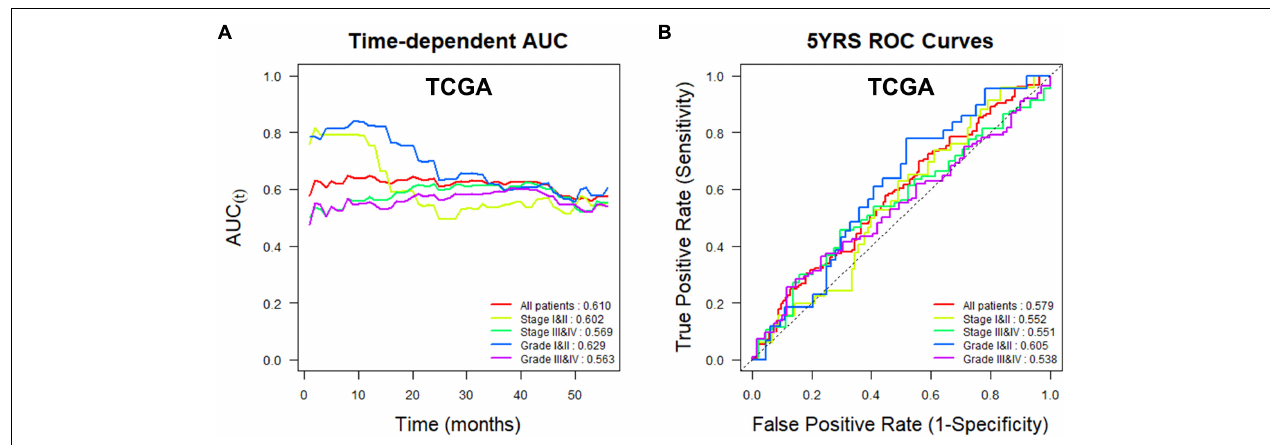
FIGURE 4 | Time-dependent area under the curve (AUC) and receiver operating characteristic (ROC) curves at 5 years according to TMED3 expression levels in the TCGA cohort. (A) Time-dependent AUC and (B) ROC curves at 5 years for patients in the TCGA cohort according to TMED3 expression levels. C-index values are shown at the bottom right in (A) . AUC values at 5 years are shown at the bottom right in (B) .